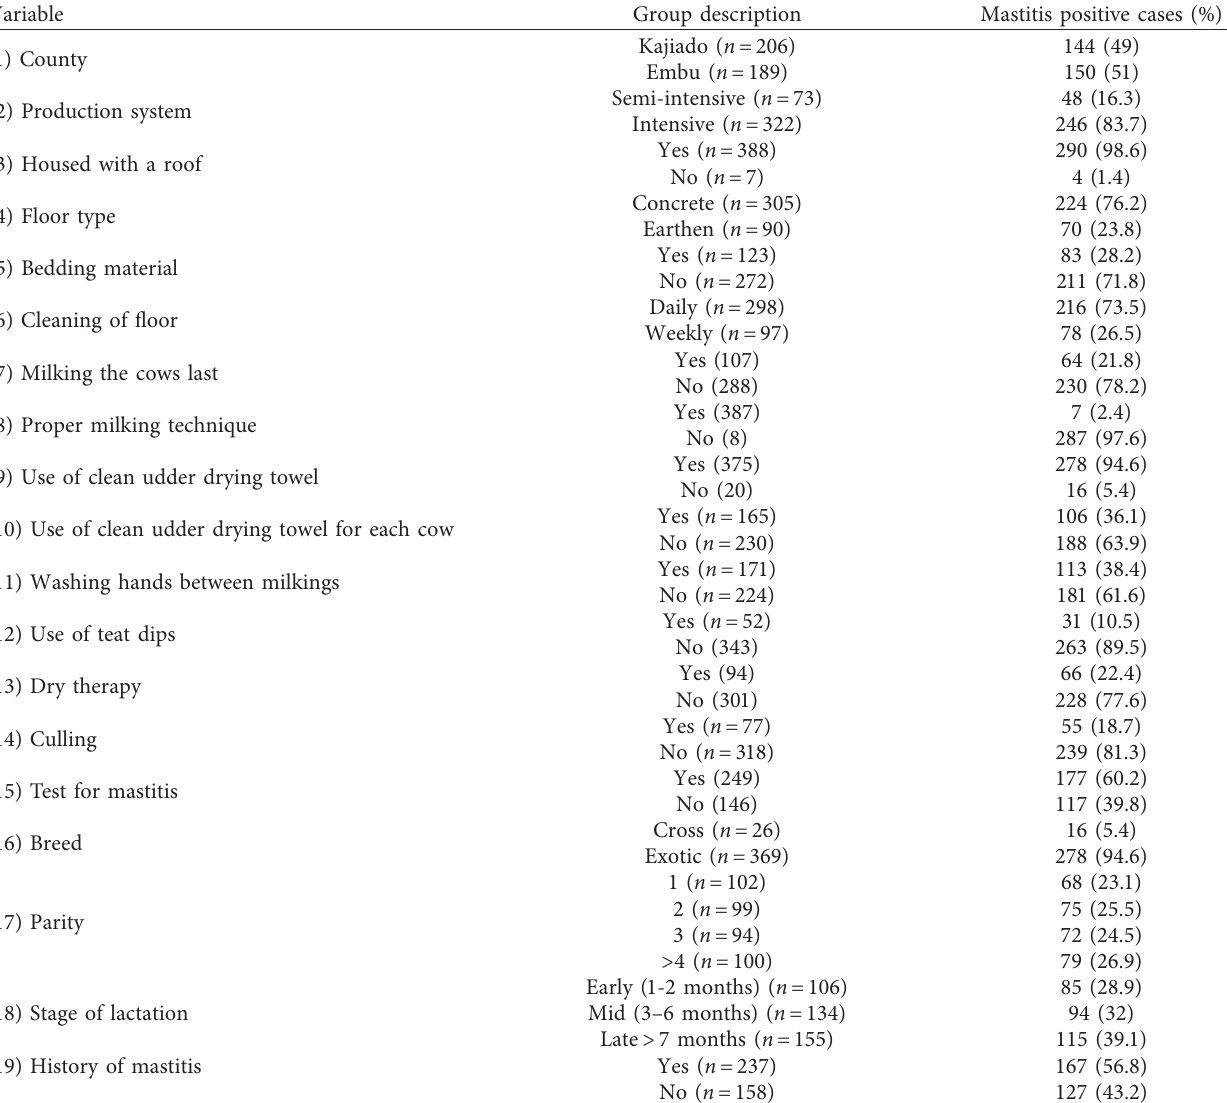
Table 3: Distribution of farm management practices and cow factors associated with mastitis in 395 dairy cows in Kajiado and Embu